Question: In a single sentence, describe what this figure presents.
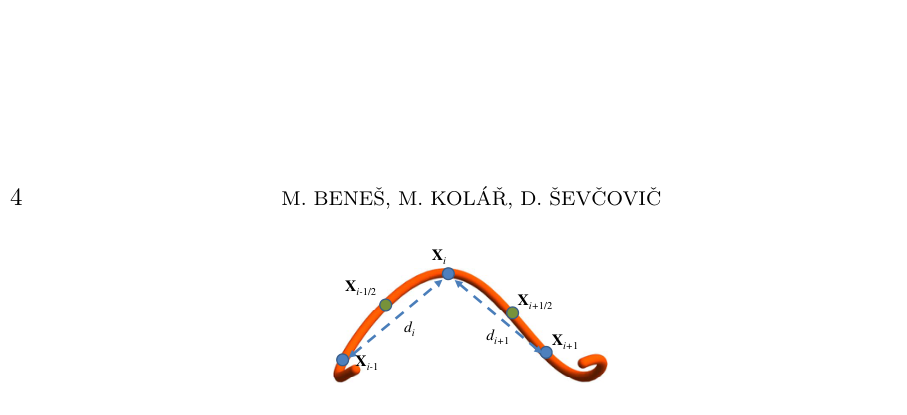
Answer: 1. Discretization of a segment of a 3D curve by the method of flowing finite volumes.